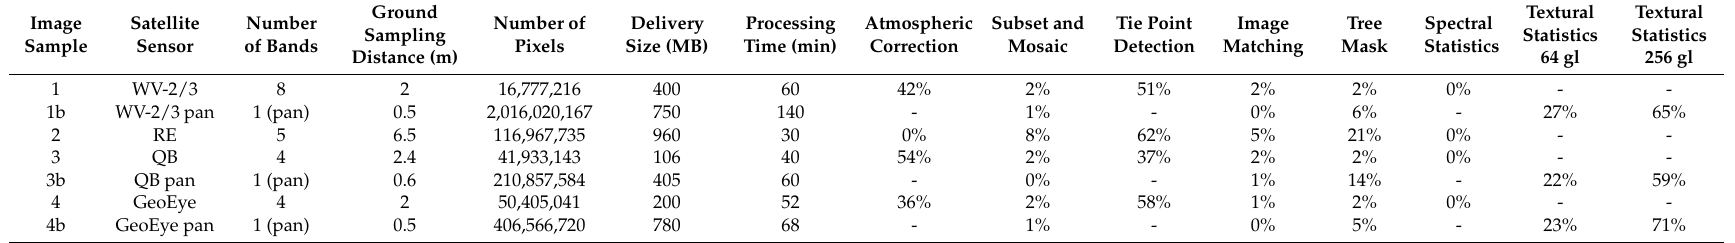
Table 2. The satellite products processed and the associated image size and time required to run the individual steps of the workflow. Image